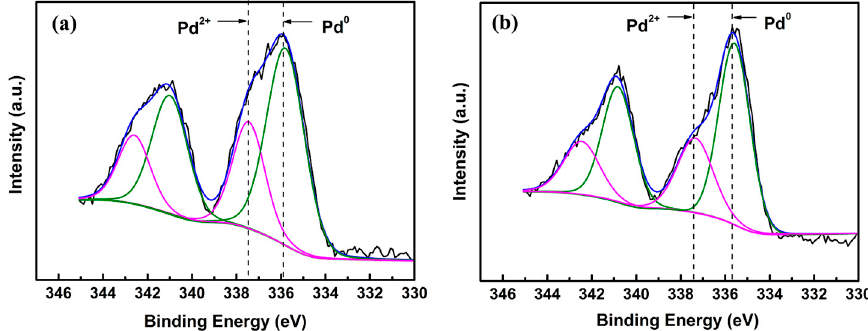
Figure 4. XPS Pd3d spectroscopy of ( a ) Pd/mb-TiO 2 and ( b ) Pd/C-mb-TiO 2 .